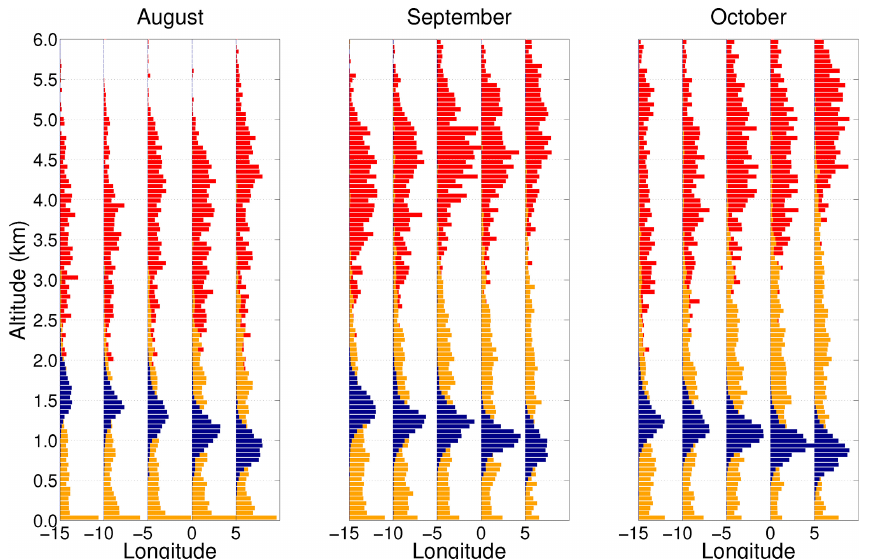
Figure 2. Distributions of aerosol top height (red), cloud top height (blue), and the separation between clouds and overlying aerosols (yel- low) as a function of longitude, between 10–22.5 ◦ S. Observations are taken from the Cloud-Aerosol Lidar with Orthogonal Polarization (CALIOP) version 3 aerosol profile product from 2006 to 2012 (7